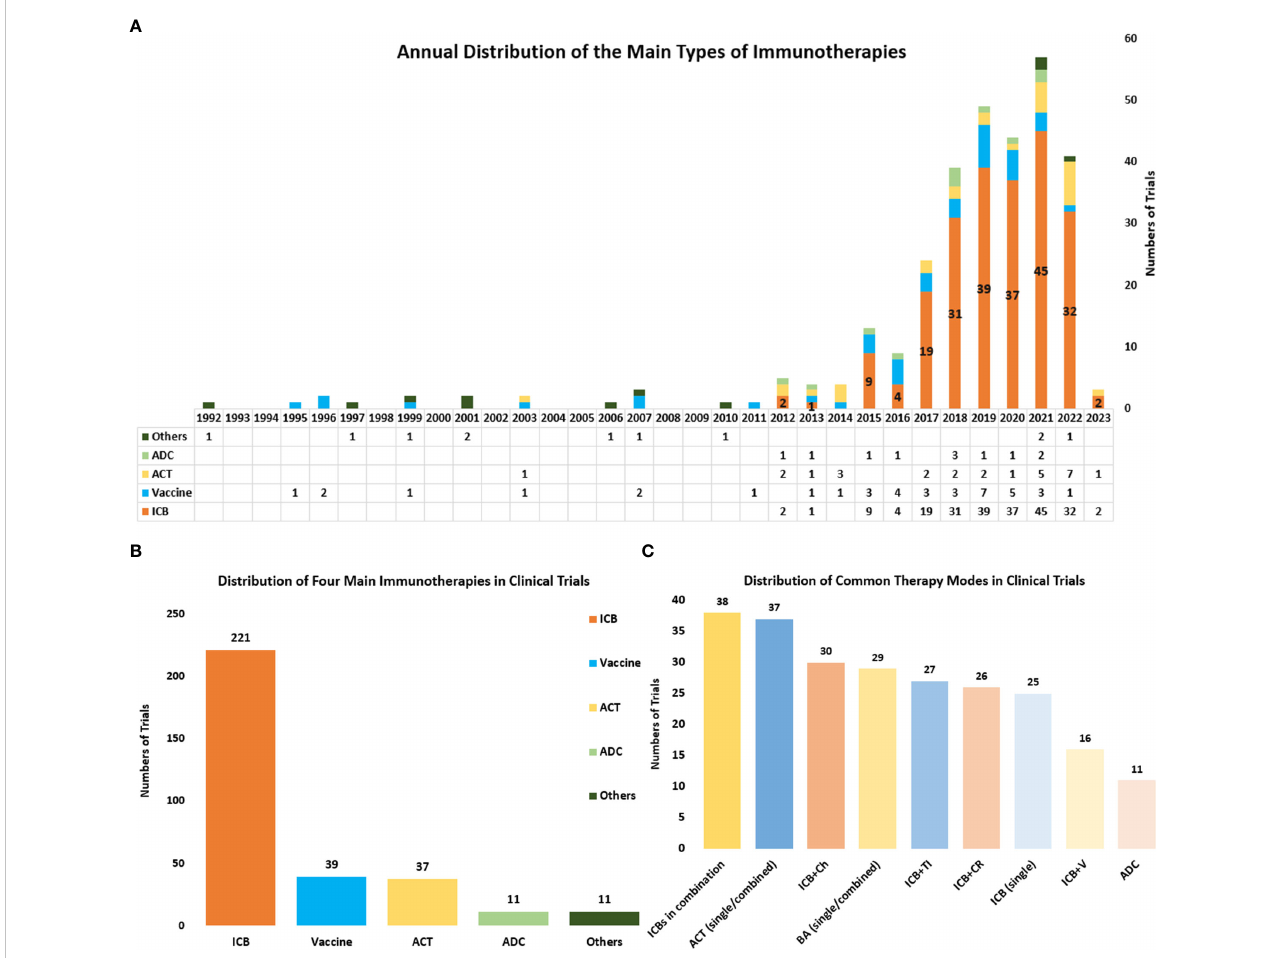
FIGURE 6 (A) The annual distribution of the main types of immunotherapies including ICBs, Vaccines, ACT, and ADC) from 1992 to 2023. Other therapies include cytokine therapy, oncolytic virus and so on, and these therapies were counted only when they were used as the main therapy. (B) The distribution of the main types of immunotherapies in all clinical trials. (C) The distribution of some common combined therapies. ICBs in combination referred to several ICBs that were used simultaneously in a clinical trial. ACT (single/combined) referred to ACT that was used as a single agent or combined with other therapies. BA (single/combined) referred to bispeci fi c antibodies that were used as a single agent or combined with other therapies ICB plus Ch referred to ICB combined with chemotherapy. ICB plus CR referred to ICB combined with chemoradiotherapy. ICB plus TI referred to ICB combined with targeted therapy. ICB plus V referred to ICB combined with vaccine